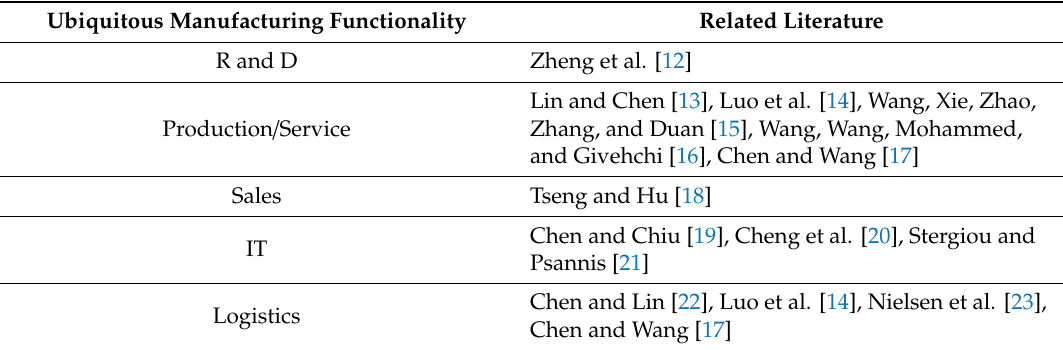
Table 1. Studies on the various functionalities that assist ubiquitous